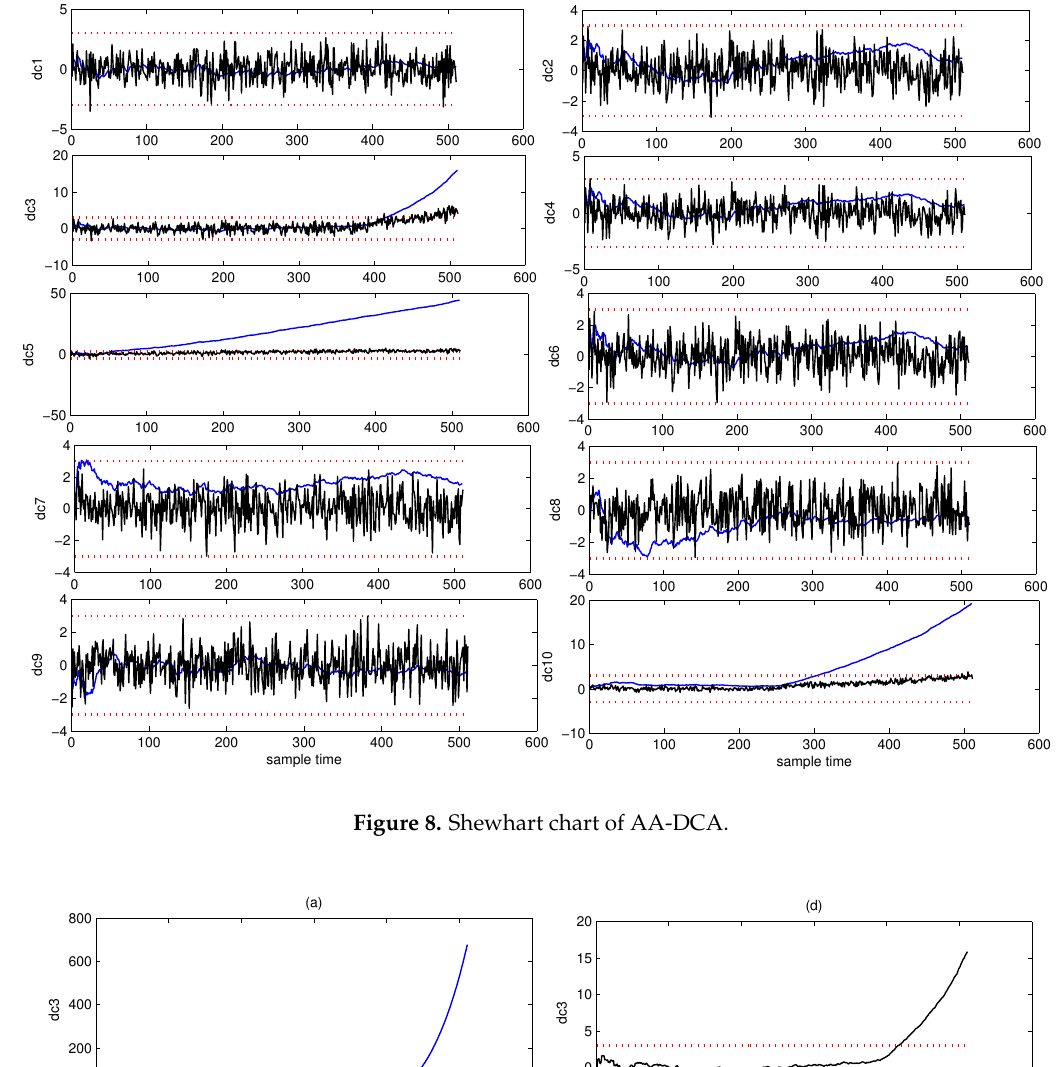
Figure 8. Shewhart chart of AA-DCA.